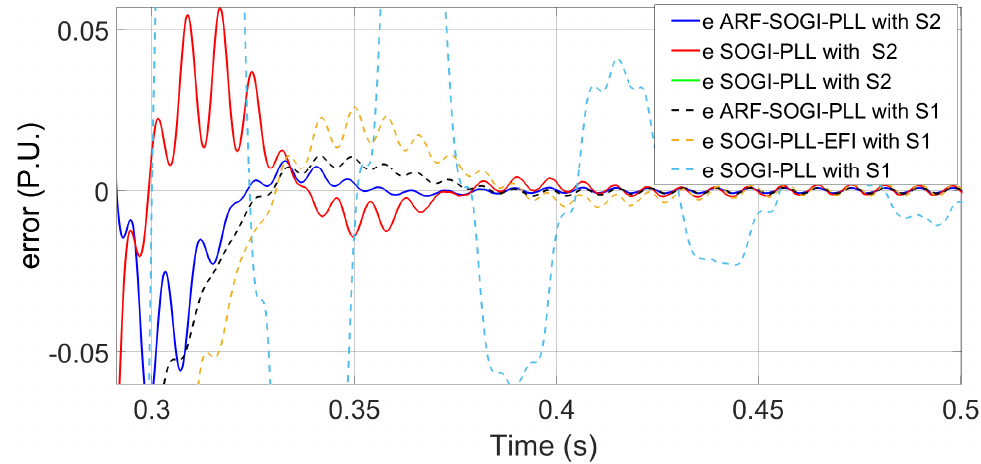
Figure 17. Phase tracking error from third to sixth cycle after system recovery from phase-to-ground